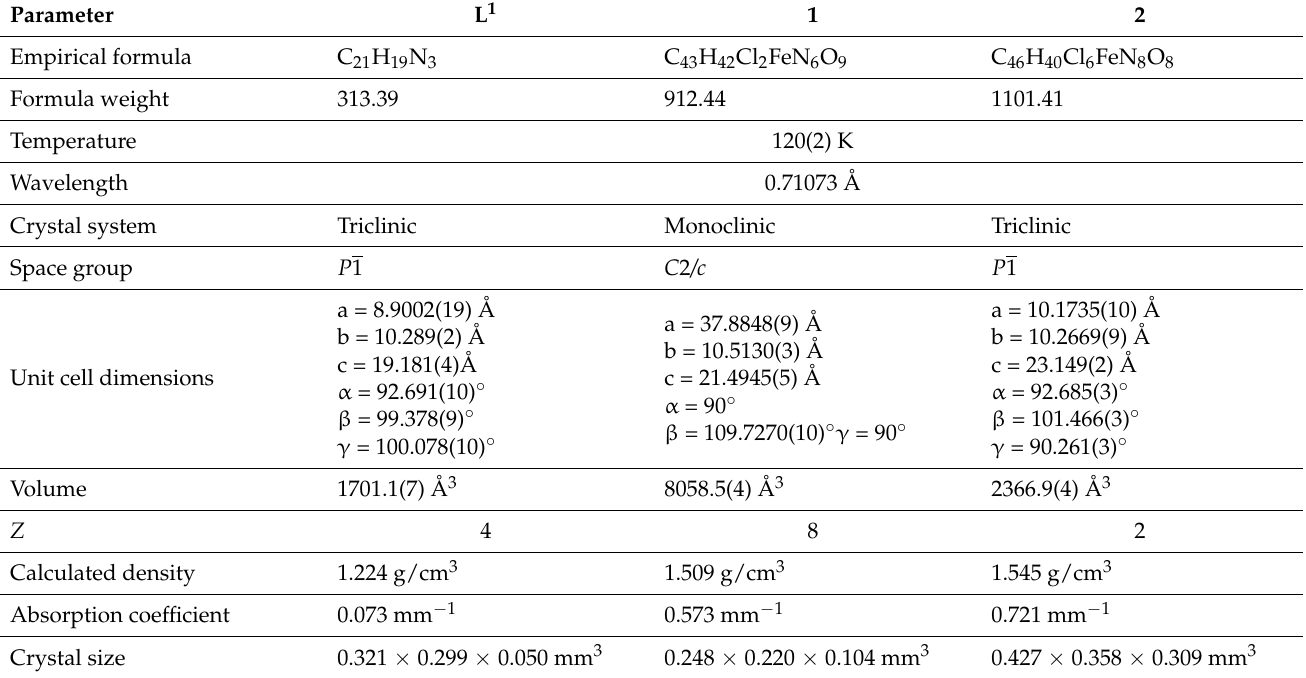
Figure 1. X-ray crystal structure of L 1 molecule in bc-axis; Color code: blue, N; grey, C; and white, H. Table 3. Collated crystal parameters data for L 1 , 1 and 2 .